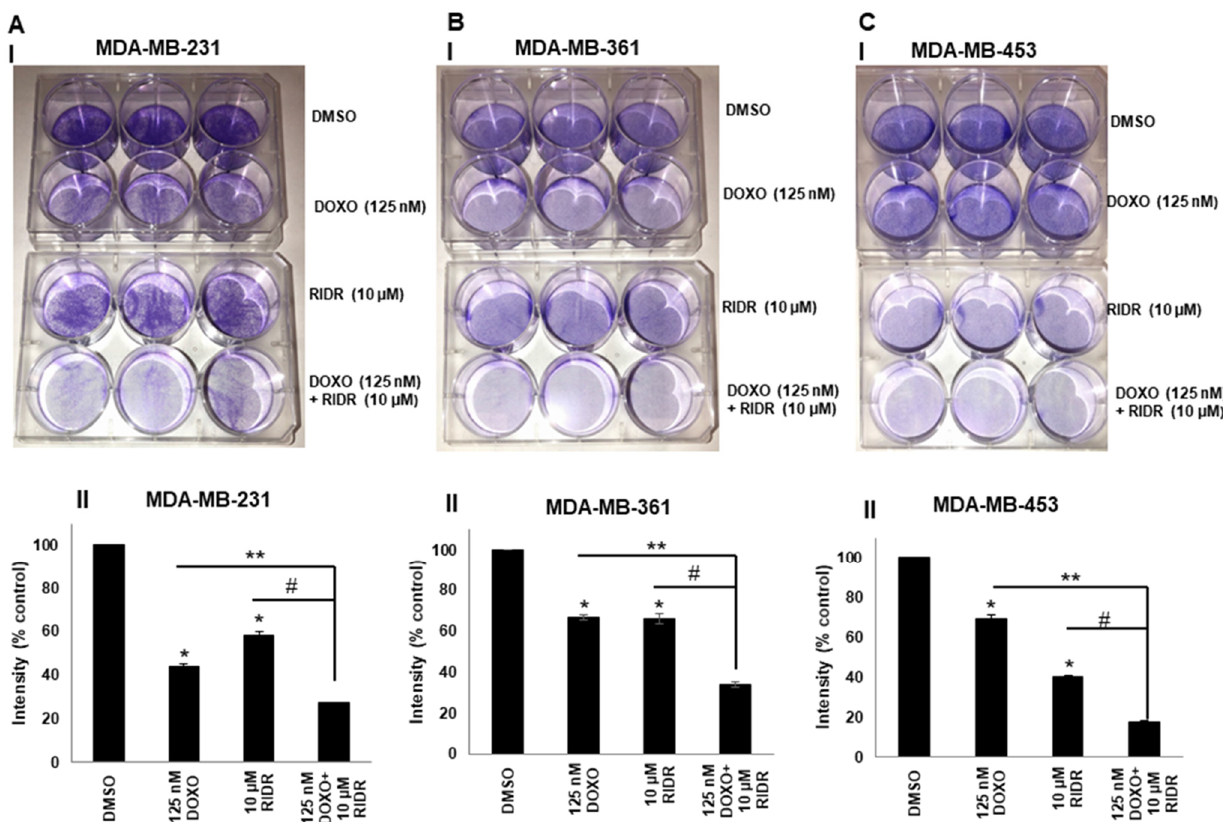
Figure 3. Combination of doxorubicin and RIDR-PI-103 inhibit breast cancer cell proliferation. ( A ) MDA-MB-231 cells (5 × 10 4 cells/well) were plated and treated with media containing vehicle (DMSO), doxorubicin (125 nM) or RIDR-PI-103 (10 µ M) and indicated combinations every second day and stained with crystal violet within 7–10 days (panel I). The intensities are represented as mean; Error bars: SEM ( n = 3 independent experiments performed in triplicate). * p < 0.05 versus DMSO and **, # p < 0.05 versus individual treatment as indicated (panel II). ( B ) MDA-MB-361 cells (5 × 10 4 cells/well) were plated and treated with media containing vehicle (DMSO), doxorubicin (125 nM) or RIDR-PI-103 (10 µM) and indicated combinations every second day and stained with crystal violet within 7–10 days (panel I). The intensities are represented as mean; Error bars: SEM ( n = 3 independent experiments performed in triplicate). * p < 0.05 versus DMSO and **, # p < 0.05 versus individual treatment as indicated (panel II). ( C ) MDA-MB-453 cells (5 × 10 4 cells/well) were plated and treated with media containing vehicle (DMSO), doxorubicin (125 nM) or RIDR-PI-103 (10 µ M) and indicated combinations every second day and stained with crystal violet within 7–10 days (panel I). The intensities are represented as mean; Error bars: SEM ( n = 3 independent experiments performed in triplicate). * p < 0.05 vs. DMSO and **, # p < 0.05 versus individual treatment as indicated (panel